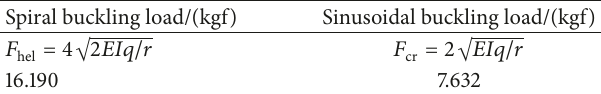
Table 6: Theoretical results of the critical loads. Figure 9: Curve of friction resistance